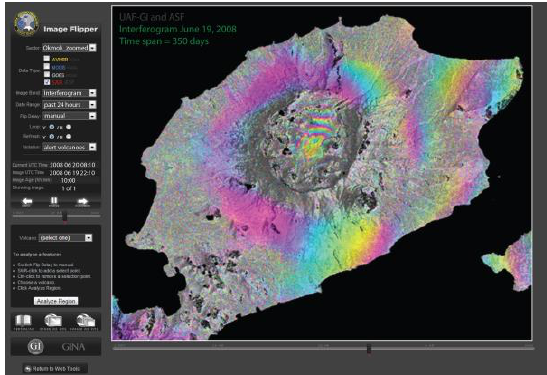
Figure 7. Screenshot of a prototype of the modified “Image Flipper”, AVO’s operational web-based monitoring system. This modified prototype adds SAR products to the list of multi- sensoral hazard information.